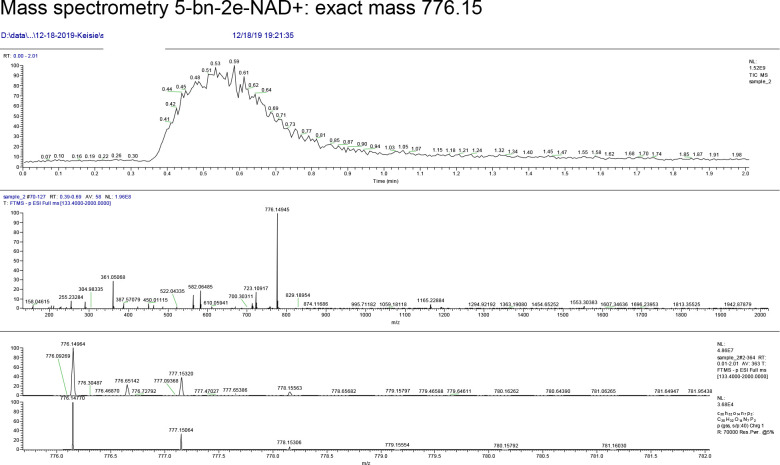
MS data for 5-benzyl-2-ethynyl-NAD+.